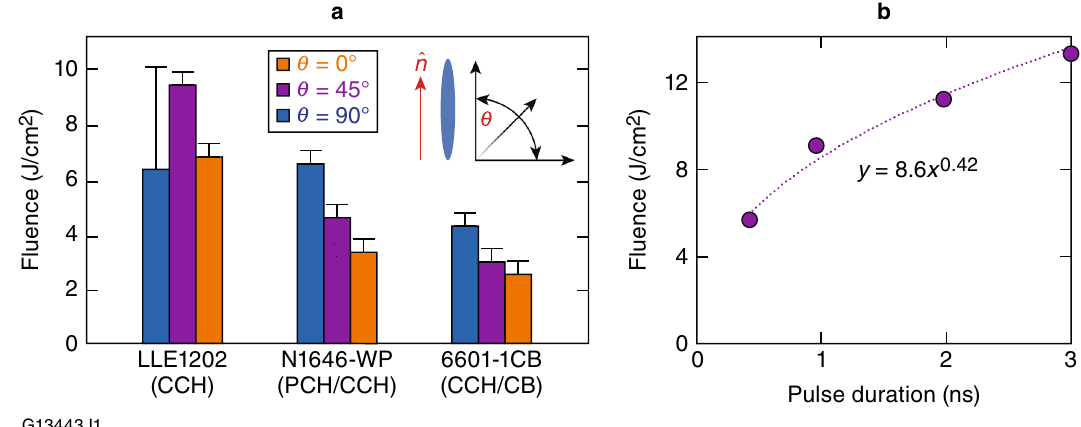
Figure 6. The 1-on-1 LIDT results at 351 nm. ( a ) LIDT at 1-ns duration as a function of incident linear polarization angle θ with respect to the LC director ñ. Uncertainty bars extend to the nominal 0% and 100% damage probability fluences. ( b ) 1-on-1 LIDT for LLE-1202 as a function of pulse duration with θ =